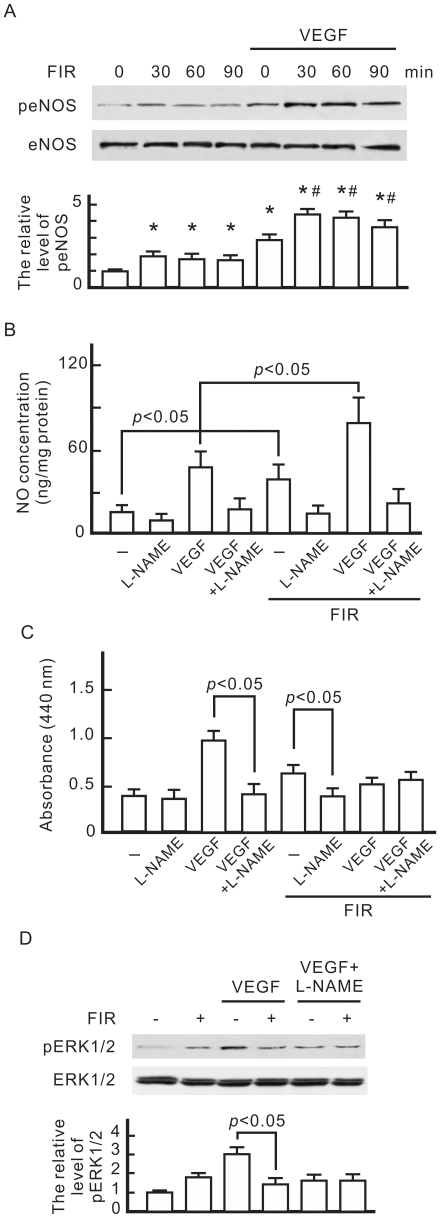
Involvement of eNOS and NO in the biological effect of FIR in HUVECs.(A) Western blotting of phospho-eNOS. HUVECs were pretreated with or without VEGF (10 ng/ml), exposed to FIR at 0.13 mW/cm2 for the indicated periods, and then cultured for 1 h. We detected eNOS as a loading control, and quantified phospho-eNOS expression relative to eNOS. By comparison with the control without FIR exposure, relative levels of phospho-eNOS were obtained and are shown as the mean±S.D. from six determinations in three cell preparations. *p<0.05 vs. the control with FIR exposure for 0 min. #
p<0.05 vs. the VEGF-treated group with FIR exposure for 0 min. (B) Detection of FIR-induced NO. HUVECs were pretreated with VEGF and NG-nitro-L-arginine methyl ester (L-NAME) (5 mM) as indicated, exposed to FIR for 30 min, and then cultured for 1 h. The NO concentration in cultured medium was detected by a nitric oxide analyzer. (C) The influence of L-NAME on cell proliferation in HUVECs. HUVECs treated as indicated were cultured overnight. Data are shown as the mean±S.D. from six experiments. (D) Western blotting of phospho-ERK1/2. HUVECs treated as indicated were cultured for 8 h. ERK1/2 was detected as a loading control. By comparison with the control without FIR exposure, relative levels of phospho-ERK1/2 were obtained and are shown as the mean±S.D. from six determinations in three cell preparations.